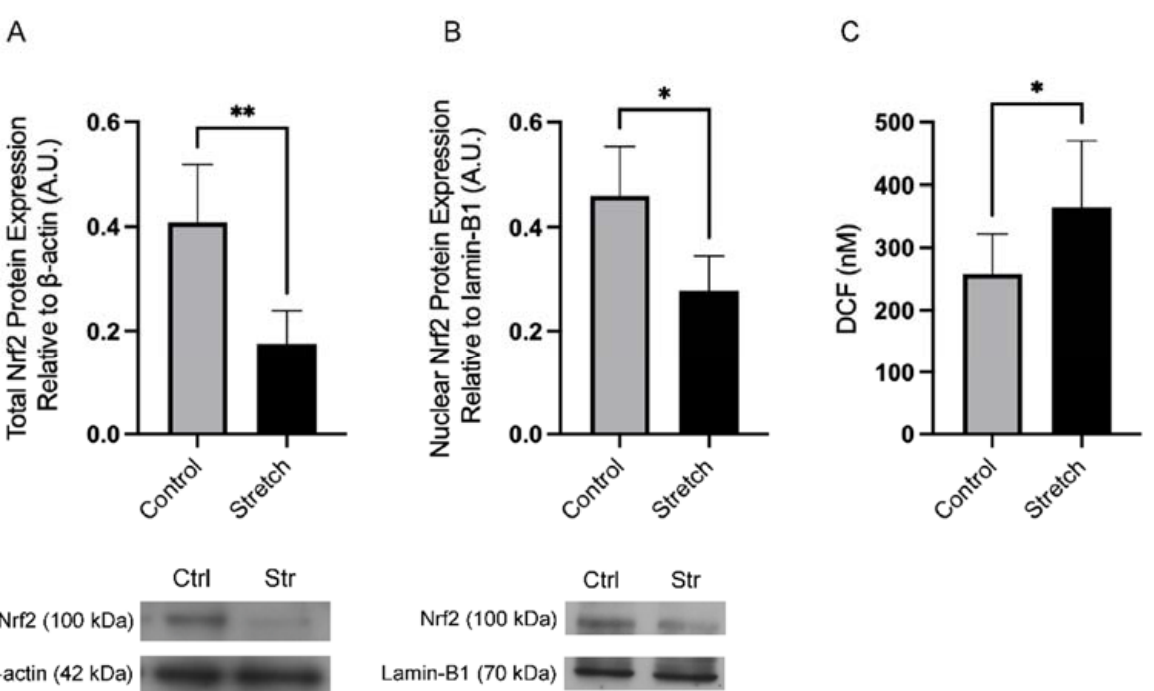
Figure 3. Stretch significantly decreased Nrf2 expression. ( A ) Whole cell lysate of Nrf2 (100 kDa) and β -Actin (42 kDa). ( B ) Nuclear lysate Western blot of Nrf2 (100 kDa) and Lamin-B1 (70 kDa) expression after 4 h of 20% cyclic stretch. ( C ) ROS generation as quantified by the production of DCF (nM) was increased with stretch. Data displayed as mean ± SEM. ** p < 0.01, * p < 0.05 vs. control (Student’s t -test).